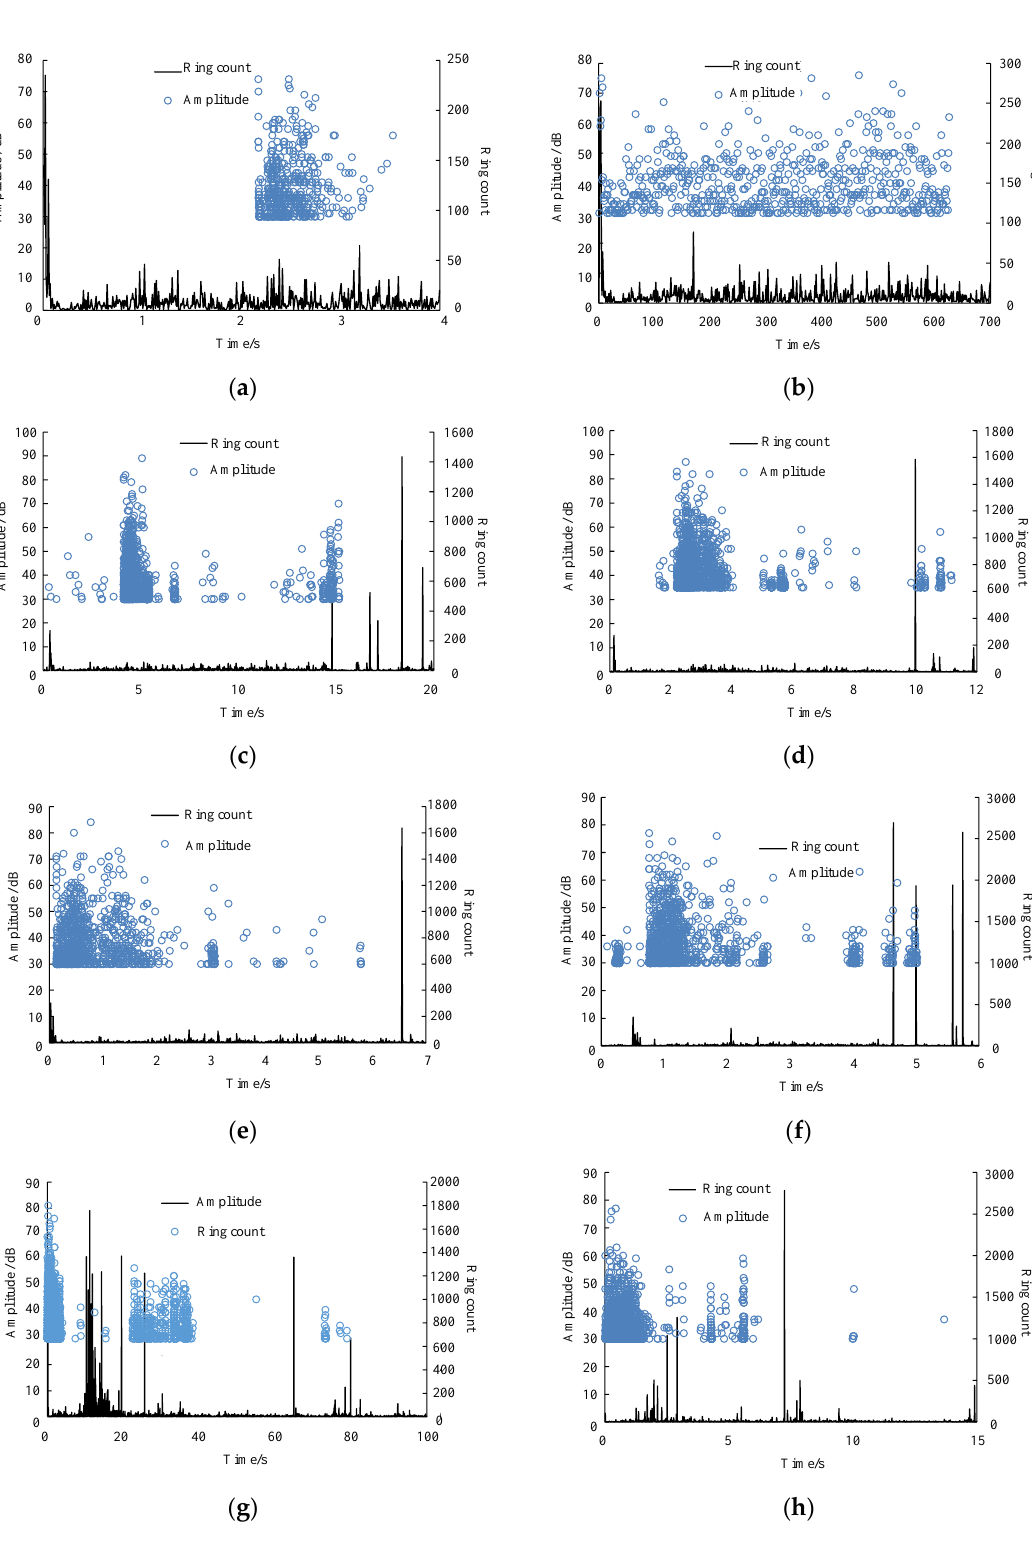
Figure 25. Characteristics of acoustic emission activity parameters. ( a ) The height of the first layer pendulum is 0.3 m; ( b ) The height of the first layer pendulum is 0.4 m; ( c ) The third layer pendulum height is 0.3 m; ( d ) The third layer pendulum height is 0.5 m; ( e ) The fifth layer pendulum height is 0.3 m; ( f ) Fifth layer pendulum height is 0.5 m; ( g ) The seventh layered pendulum height is 0.4 m; ( h ) The seventh layered pendulum height is 0.6 m.